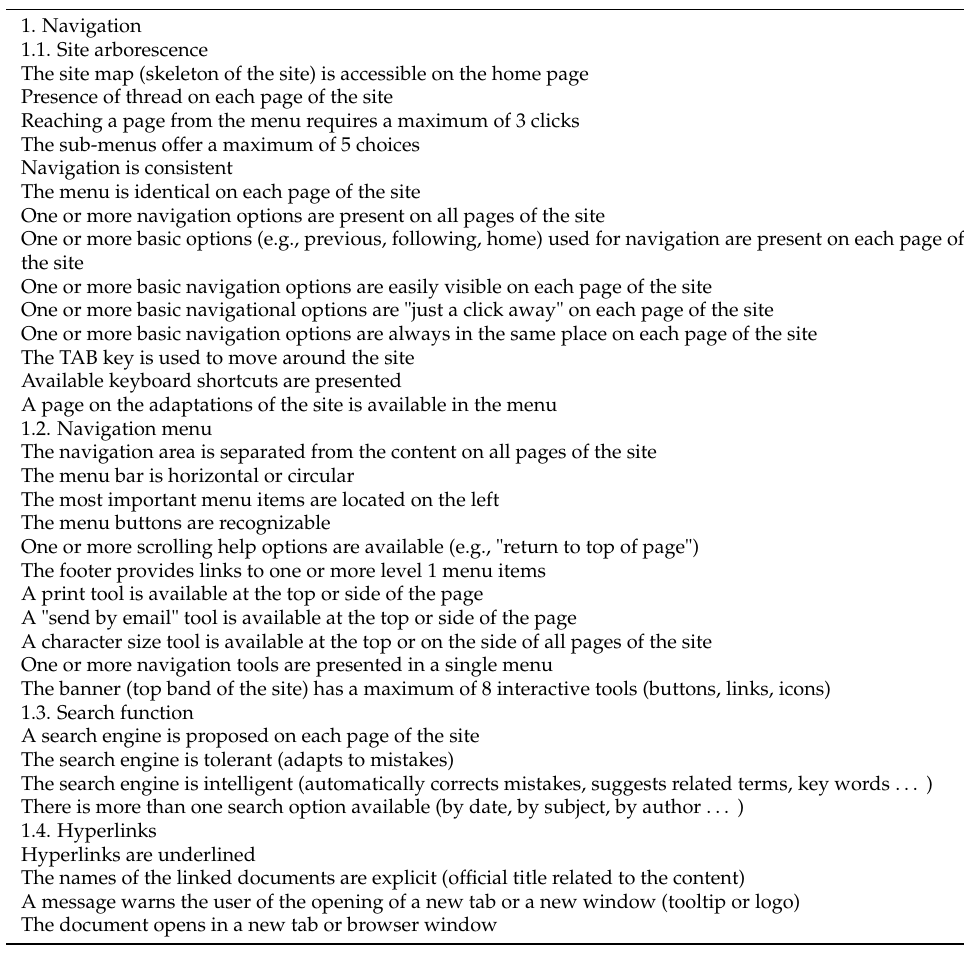
Table 1. Assessment grid. Evaluation Grids Sections and